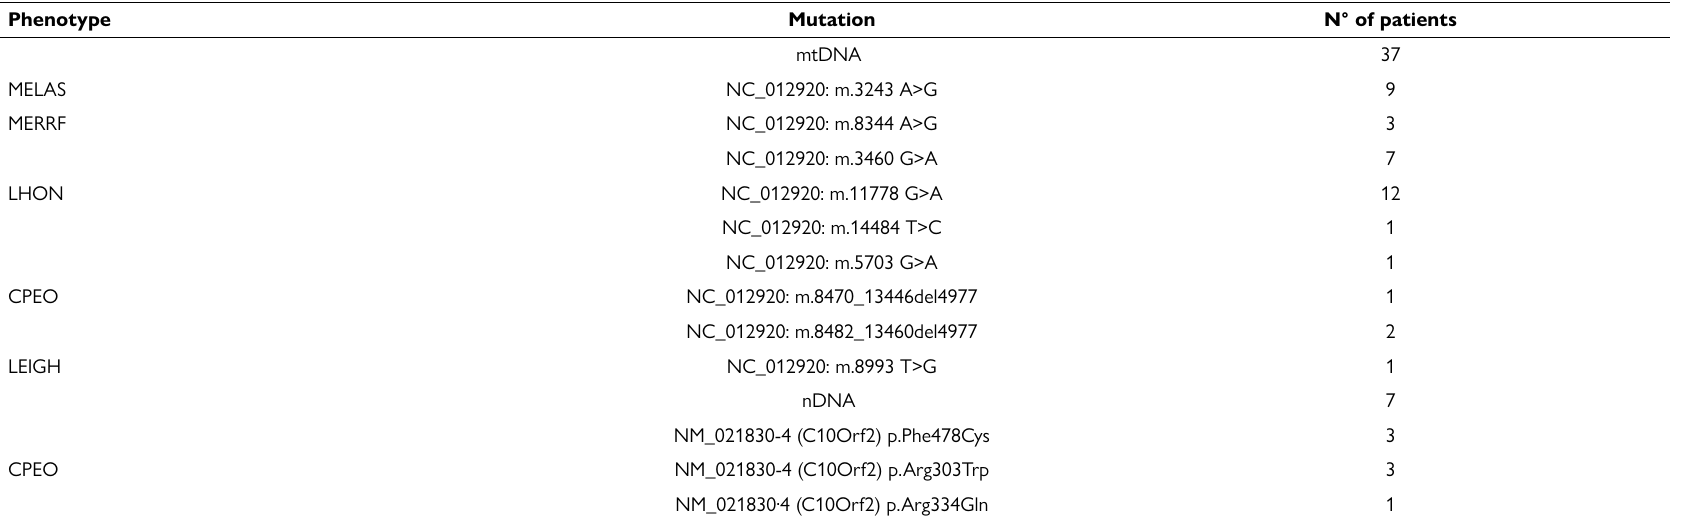
Table 2: Frequency of molecular defects in our